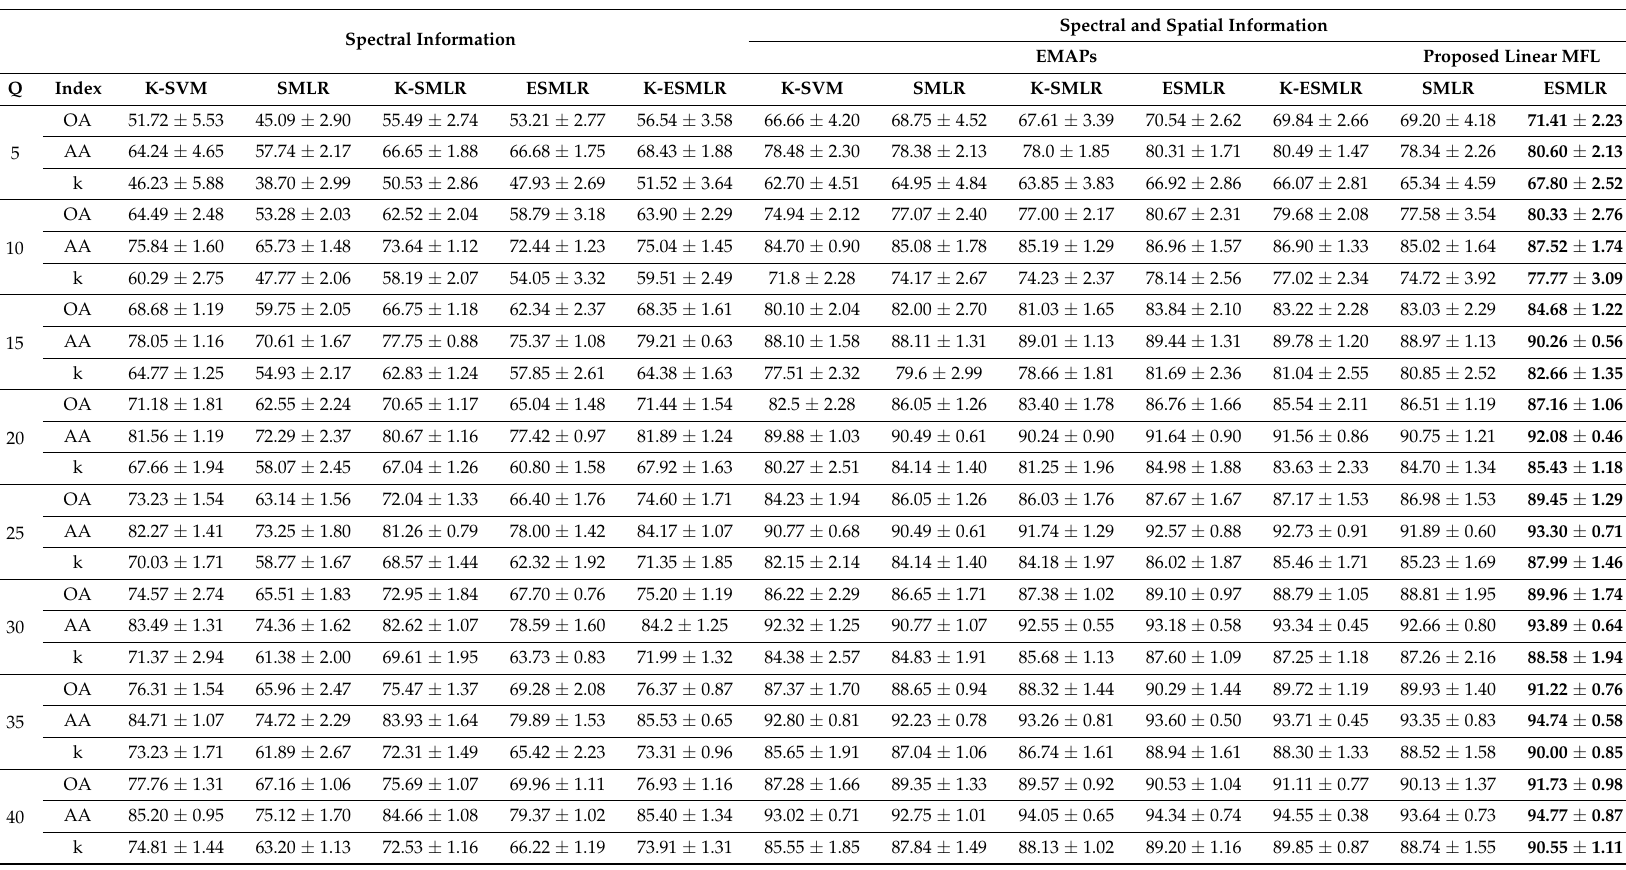
Table 3. Classification accuracy (%) with different numbers of labeled samples in Indian Pines dataset (Best result of each row is marked in bold type). Spectral Information